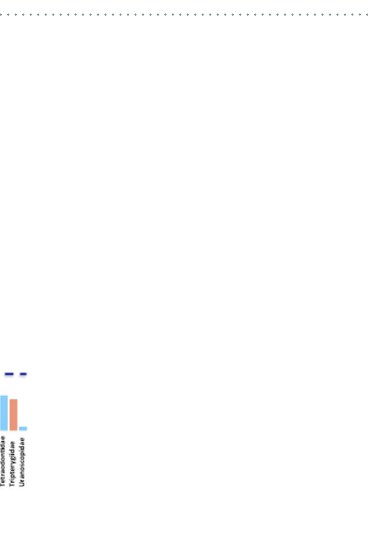
Figure 5. Number of species per Caribbean reef fish